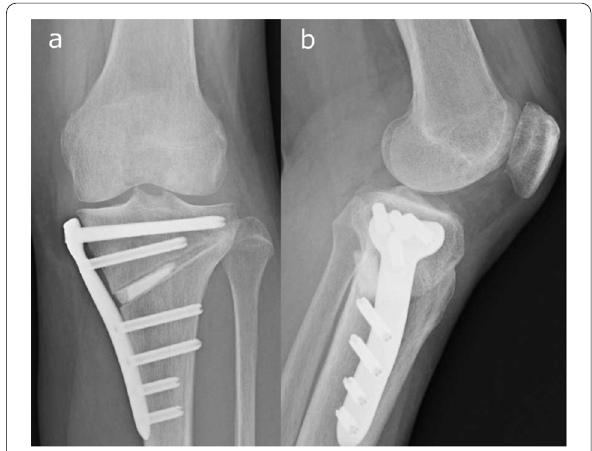
Fig. 1 Radiographs after medial open-wedge HTO. A Anteroposterior radiograph. B Lateral radiograph